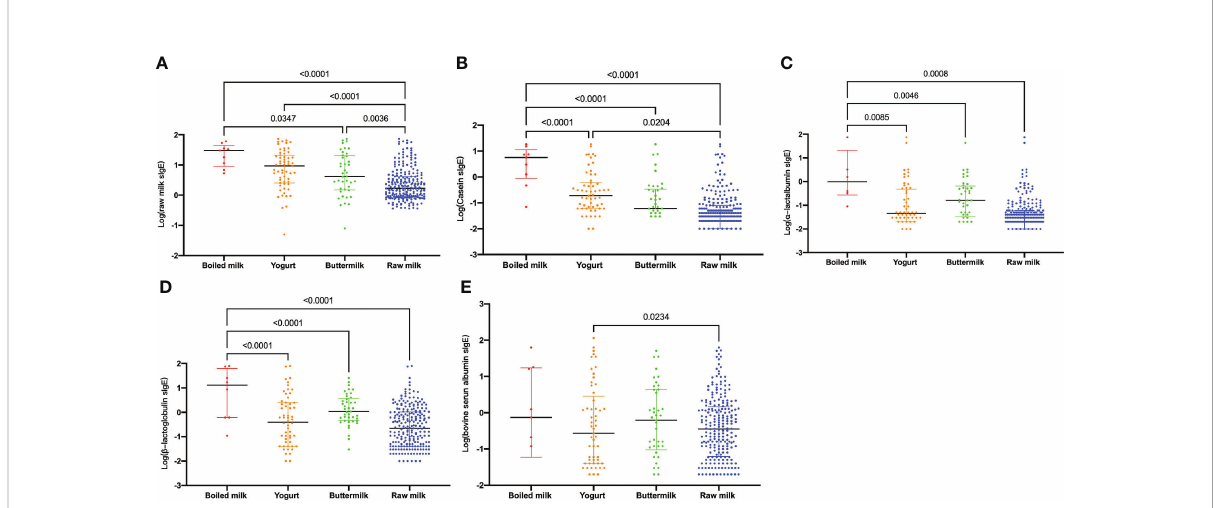
FIGURE 4 Levels of log-transformed sIgE among the four groups, namely, the boiled milk, yogurt, buttermilk, raw milk. (A) ; casein (B) ; a -lactalbumin (C) ; b -lactoglobulin (D) ; bovine serum albumin (E) . The graph shows medians and quartiles.